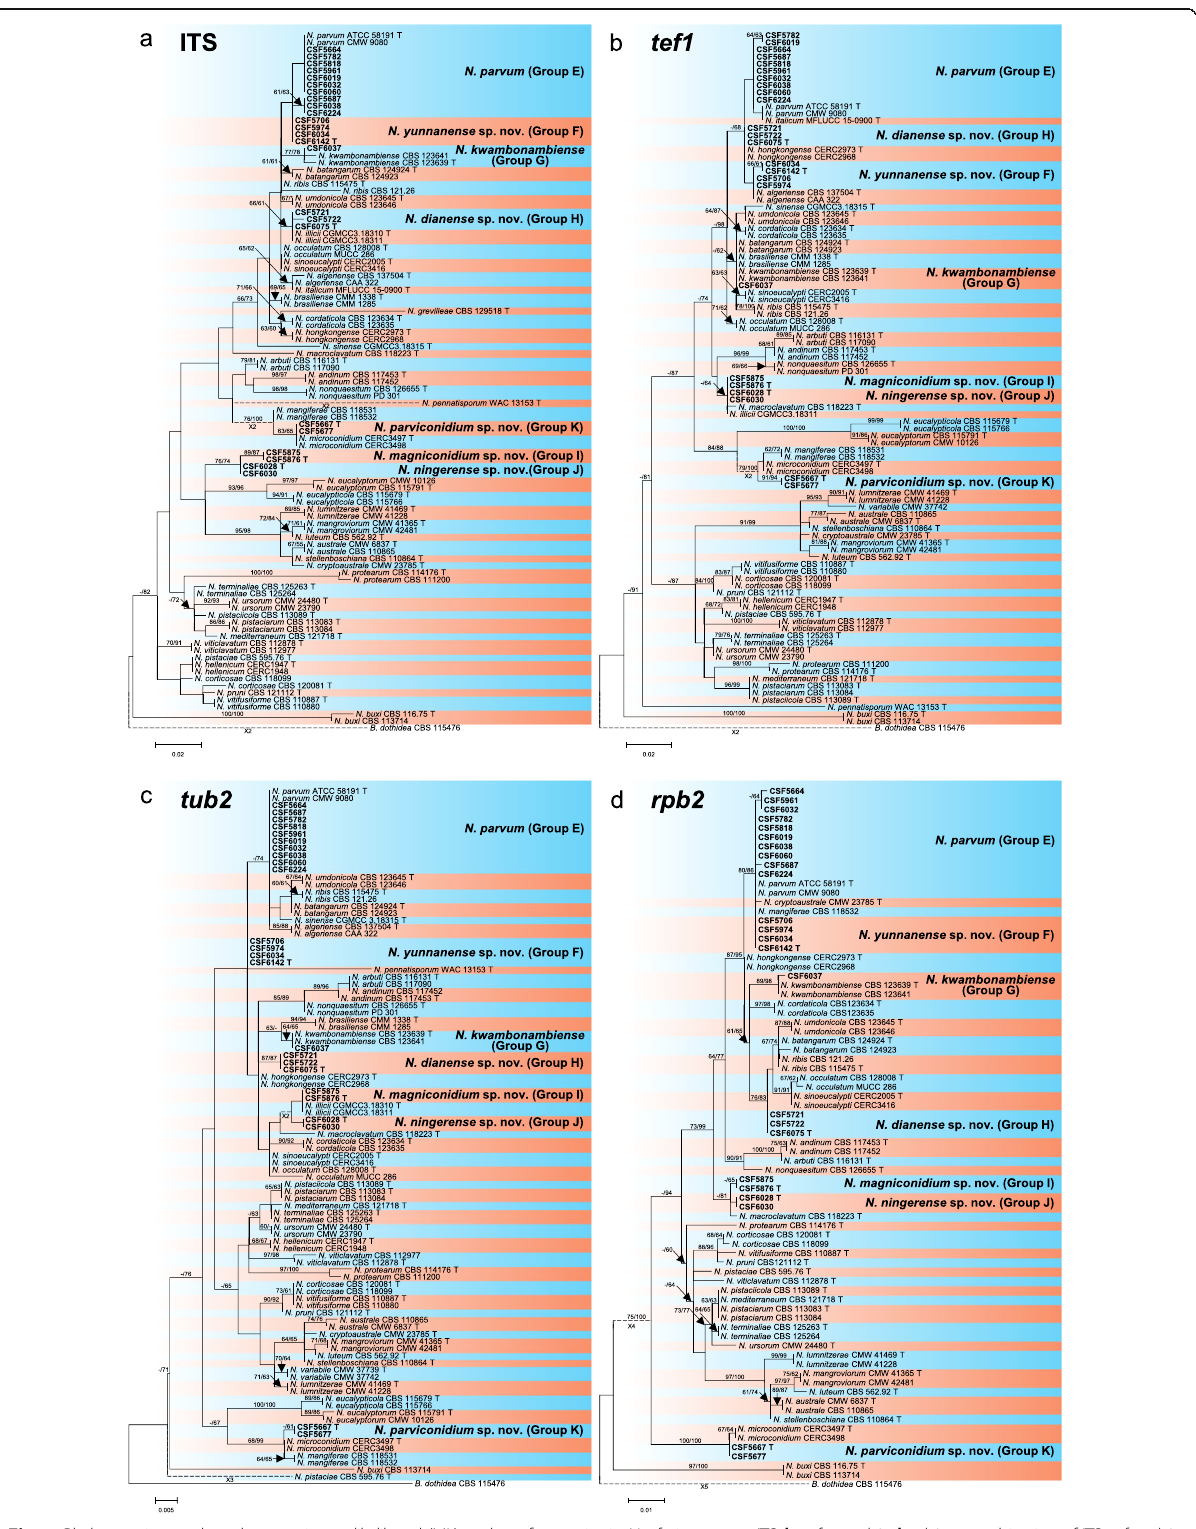
Fig. 4 Phylogenetic trees based on maximum likelihood (ML) analyses for species in Neofusicoccum . a . ITS; b . tef1 ; c . tub2 ; d . rpb2 ; e . combination of ITS, tef1 , tub2 and rpb2 . Isolates sequenced in this study are in bold. Bootstrap support values ≥ 60% for ML and MP are presented above branches as follows: ML/MP, bootstrap support values <60% are marked with ‘ - ’ , and absent are marked with ‘ * ’ . Ex-type isolates are marked with ‘ T ’ . The trees were rooted to B. dothidea (CBS